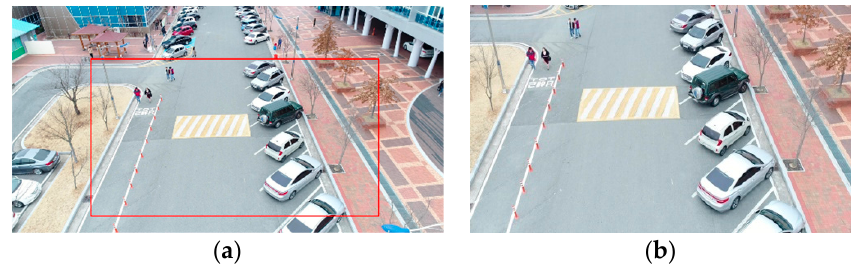
Figure 7. ( a ) Sample frame (4096 × 2160 pixels), ( b ) cropped region after resizing (550 × 300 pixels).